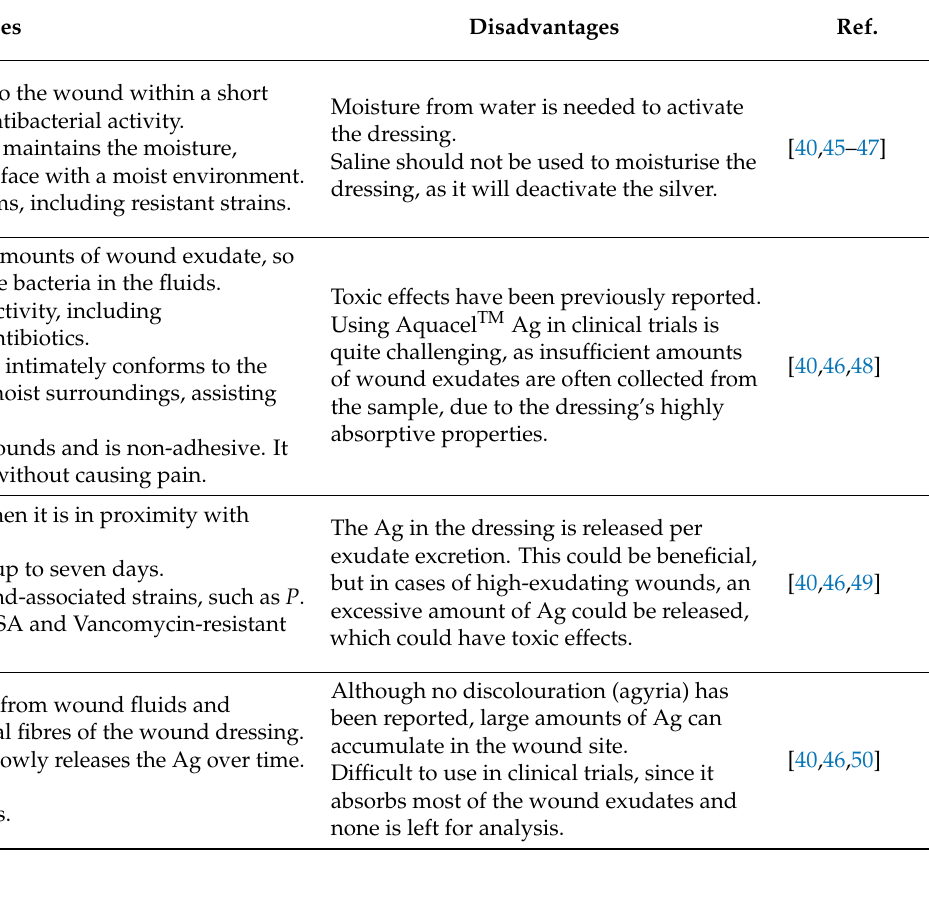
Table 1. Advantages and disadvantages of the commercial silver-based wound